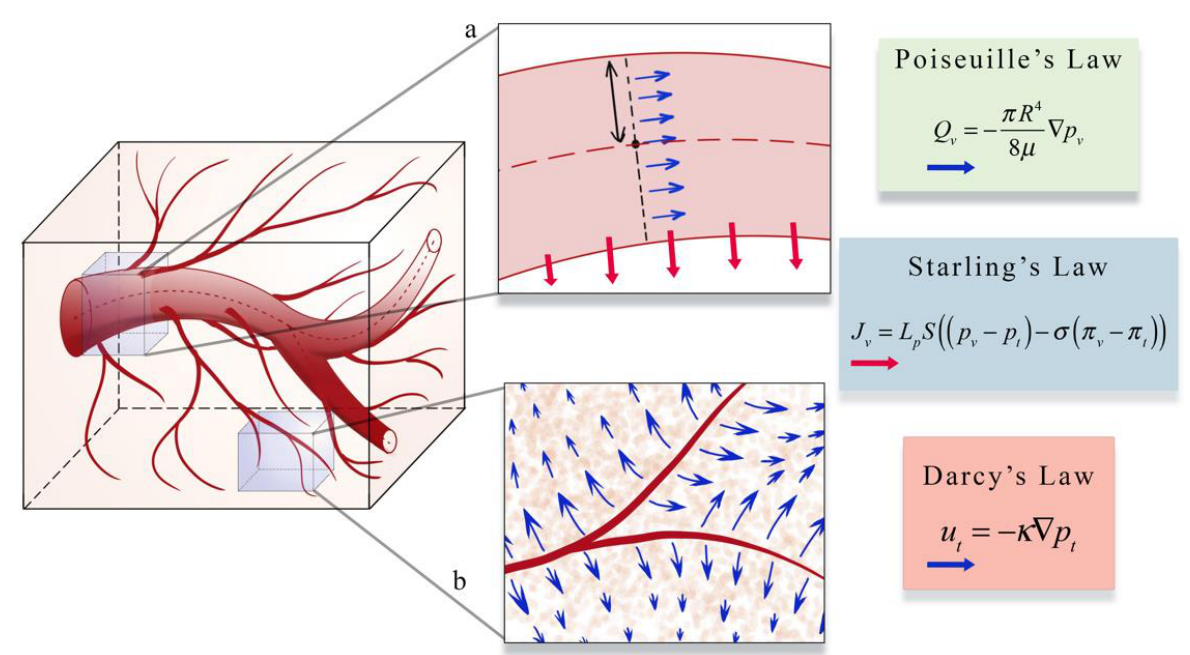
Figure 5. Illustration of a perfusion and transport model. Intravascular and interstitial flow is characterized by the laws of Poiseuille, Starling, and Darcy. Inset a illustrates Poiseuille’s and Starling’s law. Poiseuille’s law relates intravascular flow ( Q v , blue arrows in inset a ) to the radius of the vessel ( R ), the dynamic viscosity of blood μ , and the gradient of the intra- vascular pressure p v . Starling’s law relates the rate of extravasation ( J v , red arrows in inset b ) to the hydraulic conductivity of the vessel wall ( L p ), the vascular surface area ( S ), the reflection coefficient ( σ ), the vascular oncotic pressure ( π v ), and the interstitial oncotic pressure ( π t ). Inset b shows an illustration of Darcy’s law which relates the interstitial flow velocity ( m t , blue arrows in inset b ) to the interstitial tissue hydraulic conductivity (κ ), and the gradient of interstitial pressure ( p t ). These three relations are found throughout the literature on the physical modeling of tumor associated vascular flow and angiogenesis.